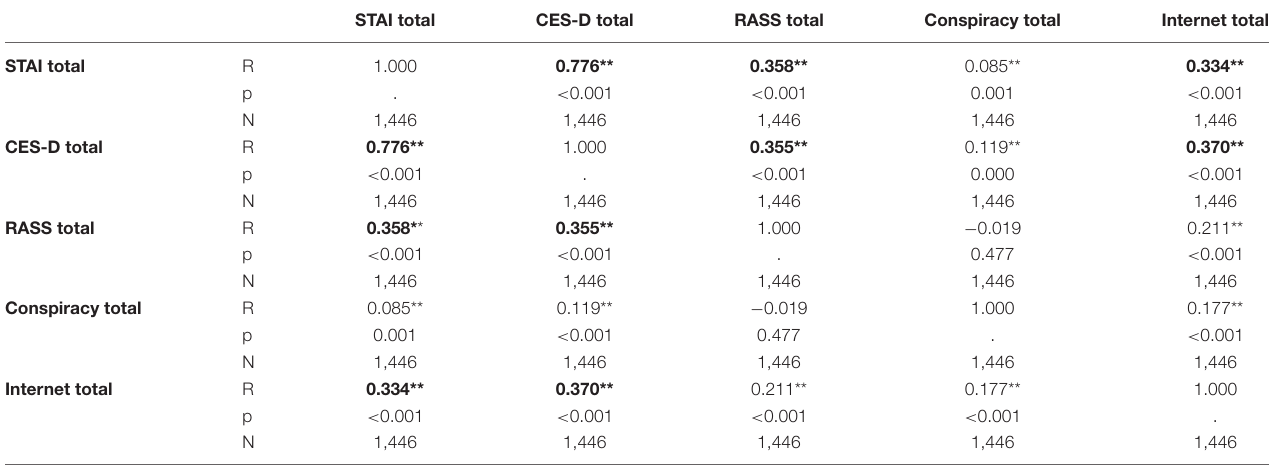
TABLE 5 | Associations between the scales total scorings on anxiety, depression, suicidality, conspiracy beliefs and Internet use. STAI